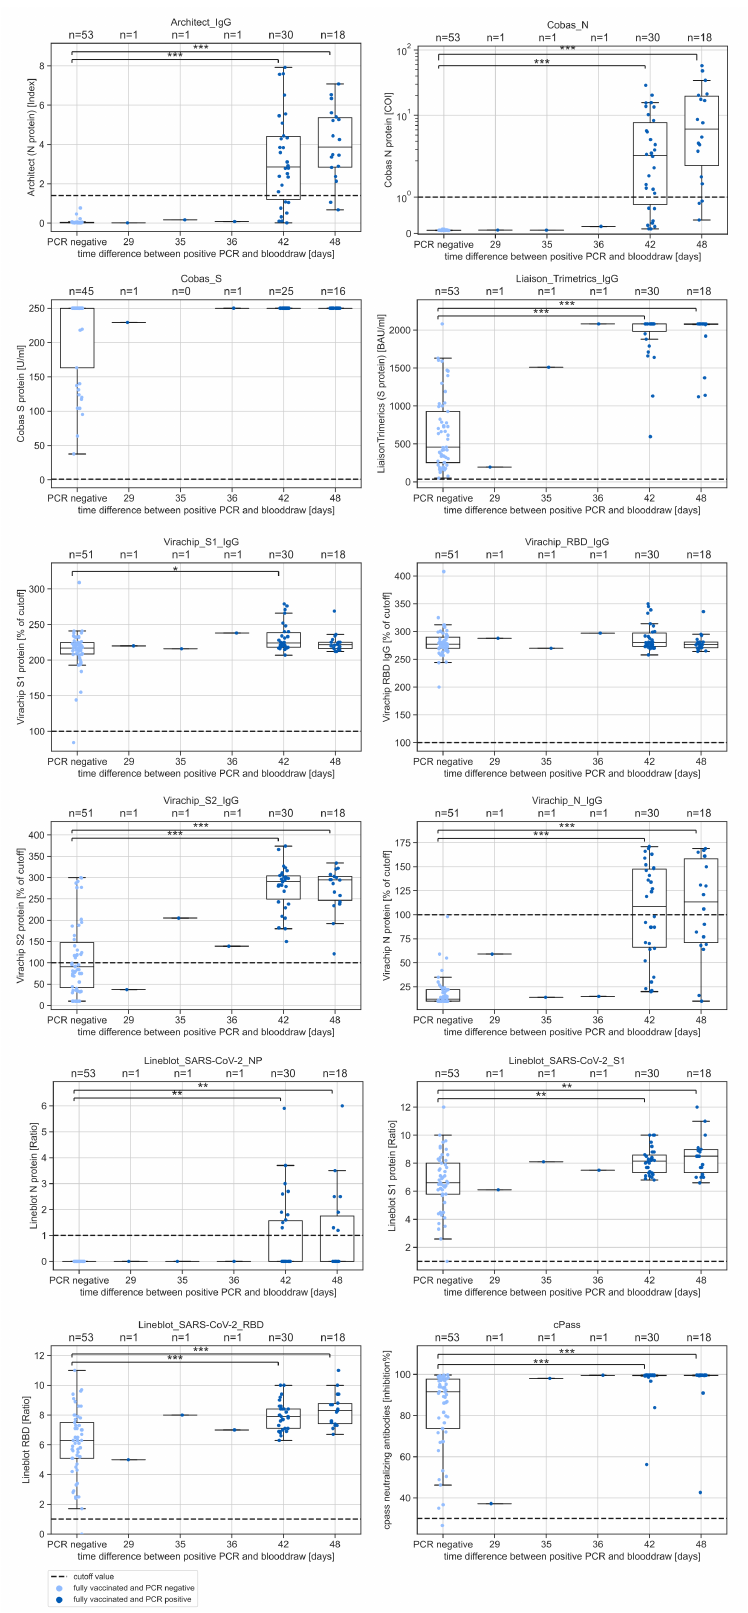
Figure A4. Measurement values for each assay in dependence of time difference between PCR and blood-draw. Dashed line represents cut-off value. Wilcoxon rank sum test with *: p < 0.05, **: p < 0.01, ***: p <